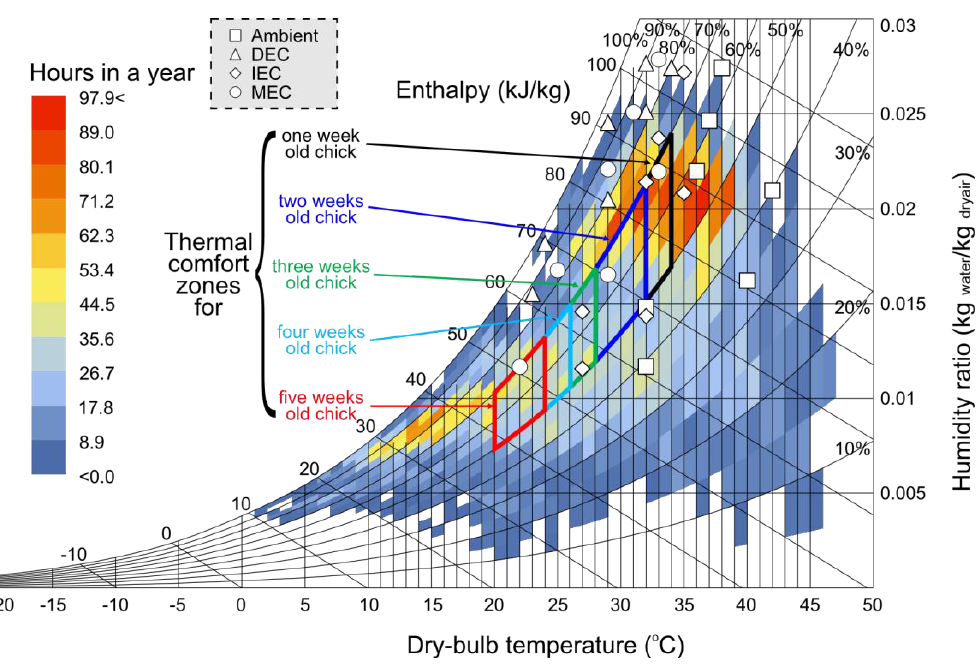
Figure 13. Annual profile of THI resulting from the EC systems for climatic conditions of Multan. The red dotted line shows the optimum level of THI i.e., 30.